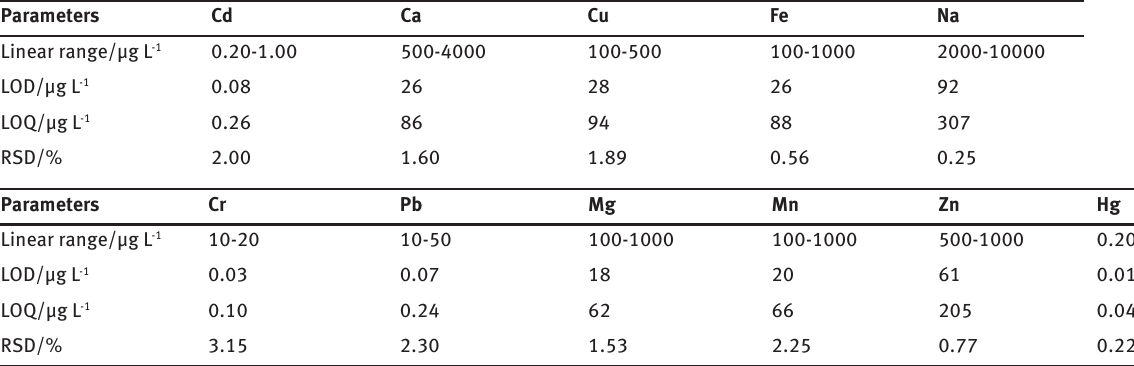
Table 2: Linear range, LOD, LOQ and RSD for all surveyed metals.